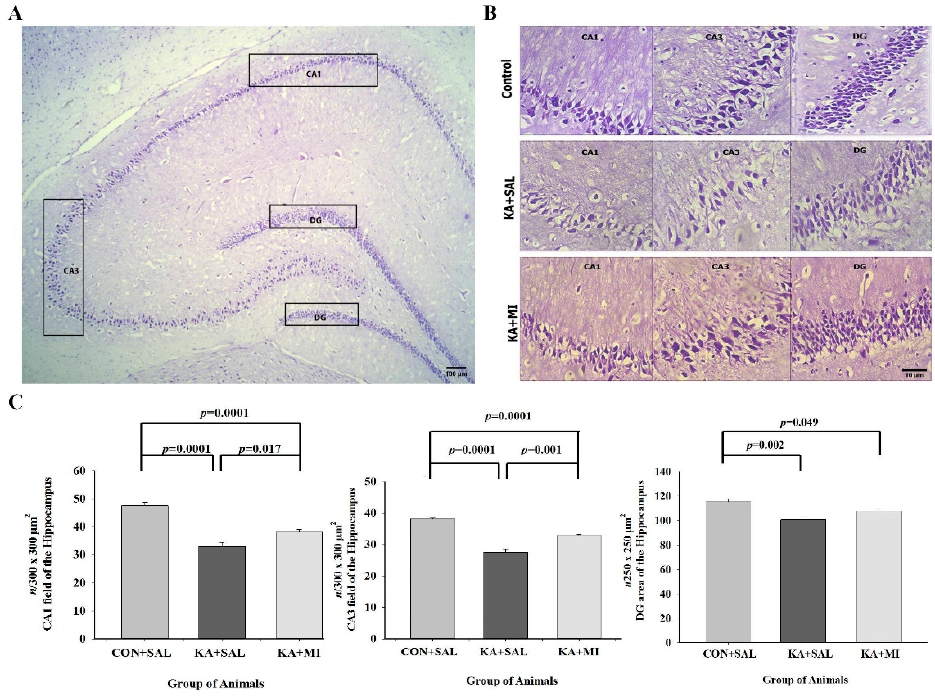
Figure 3. MI treatment prevents the KA-induced cell decrease in the hippocampus-the morpholog- ical changes in hippocampus subfields of three experimental groups. ( A )—the view of hippocampus subfields, where cell counts were performed; ( B )—representative photomicrographs of Nissl staining sections from the hippocampus of Control, KA + SAL and KA + MI group of rats; ( C ) Mean numbers of neurons in the CA1, CA3 and DG subfields of hippocampus in three different group of animals.